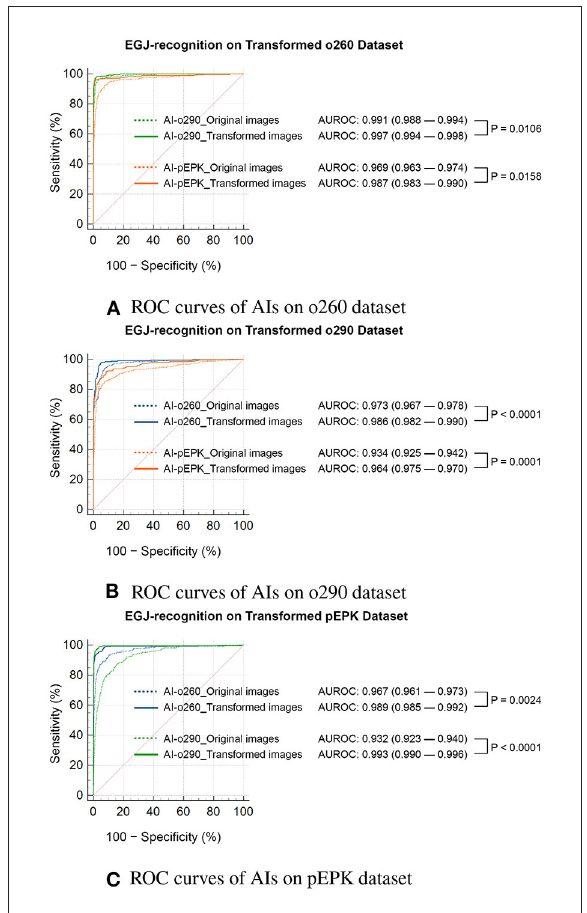
FIGURE6 Statistical comparison of the ROC curves of EGJ-recognition AIs on transformed validation datasets. ROC curves of AIs on (A) o260, (B) o290, and (C) pEPK dataset. Compared with the results on the original dataset (indicated by dotted lines), the EGJ-recognition AIs performed better in the transformed dataset (indicated by solid lines) to represent the image characteristics used in the training process. (A,B) The recognition rate of AIs improved on the transformed Olympus endoscope images to optimize for the model the AI trained on. The AI trained with PENTAX endoscope images showed greater improvement. (C) The performance of AIs trained with Olympus endoscope images also improved on the transformed PENTAX endoscope images. o260, Olympus CV-260SL; o290, Olympus CV-290; pEPK, PENTAX EPK-i; AI, artificial intelligence;